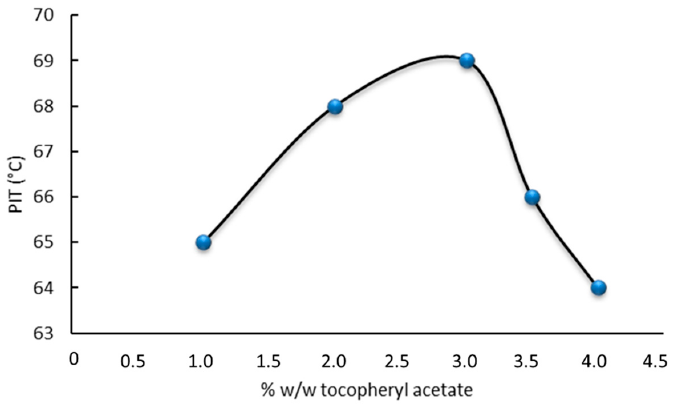
Figure 3. Relationship between PIT values and% w / w of tocopheryl acetate of NLC loaded with IDE 1.5% w / w .